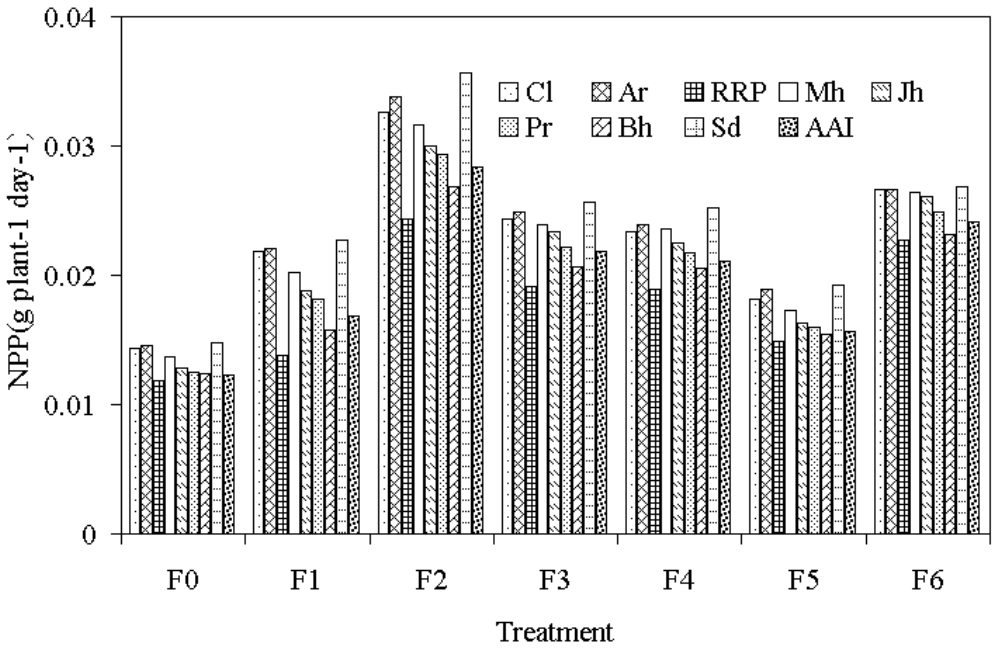
FIGURE 4. Effect of different fertility levels on leaf area of wheat plants grown at various sites.